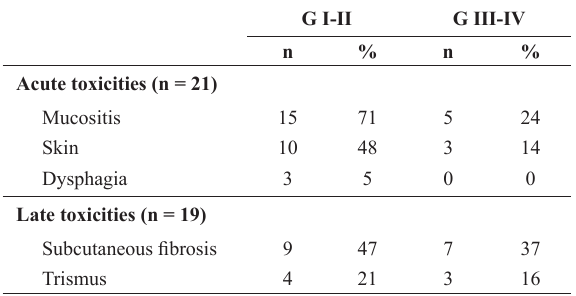
Table 5: Toxicity